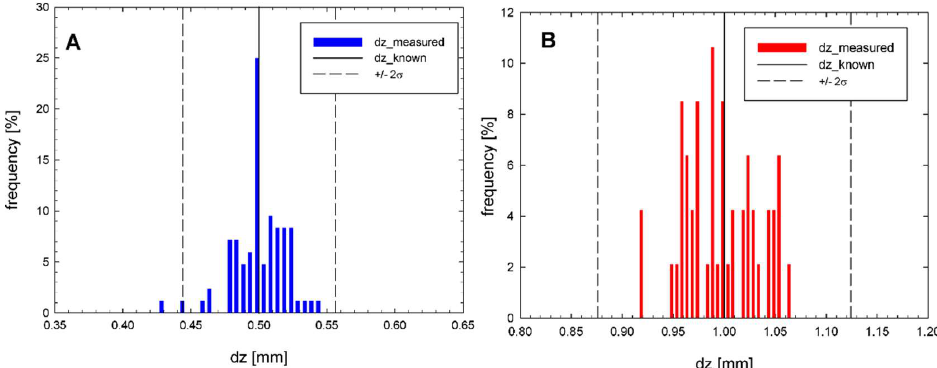
Figure 4. Vertical measuring accuracy of PHOTOSED for given incremental vertical shifts of dz = 0.5 mm ( A ) and dz = 1.0 mm ( B ). The dashed lines represent the median ± the doubled standard deviation ( ± 2 σ ).